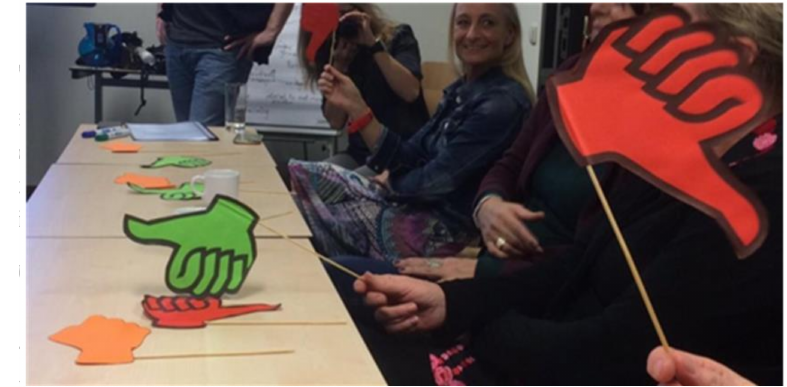
Figure 2. Overview of thumbs used for the focus group sessions.